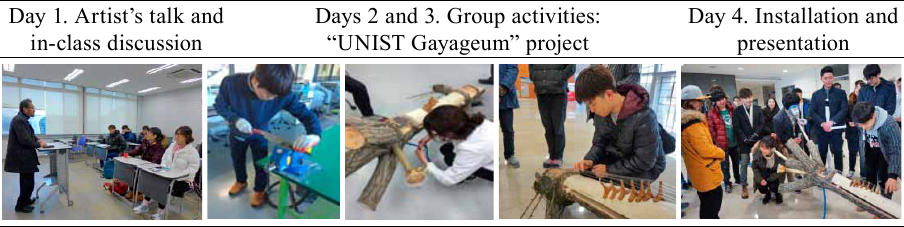
Table 5. Work process of group a (created by author) Day 1. Artist’s talk and in-class